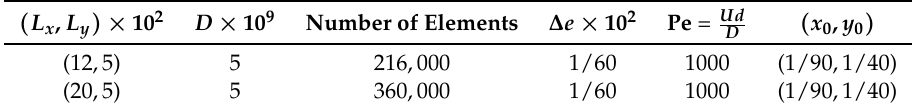
Table 1. Parameter values used for the COMSOL simulations in this paper. All of the quantities are in S.I.